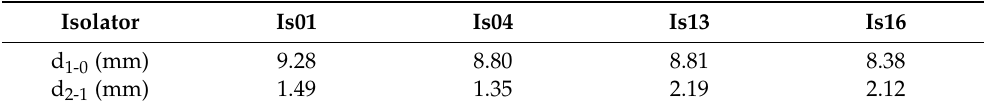
Table 3. Maximum relative displacement d 1-0 between L1 and L0, and d 2-1 between L2 and L1, at the points corresponding to the position of the corner isolation devices.